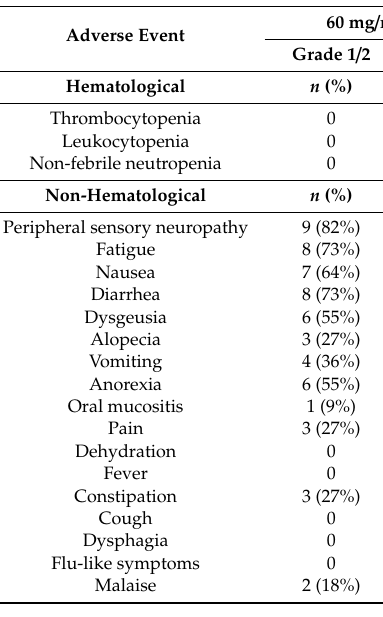
Table 2. Treatment-related adverse